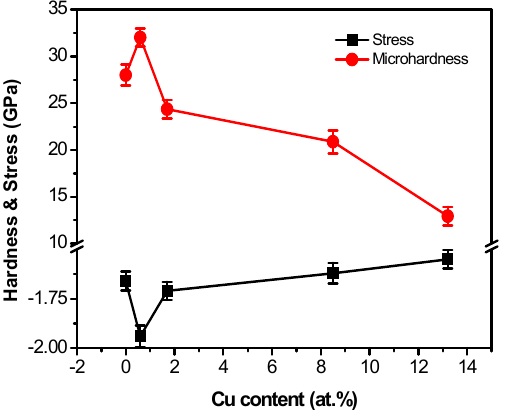
Figure 6. Micro-hardness and stress of VCN–Cu composite films with different Cu contents.